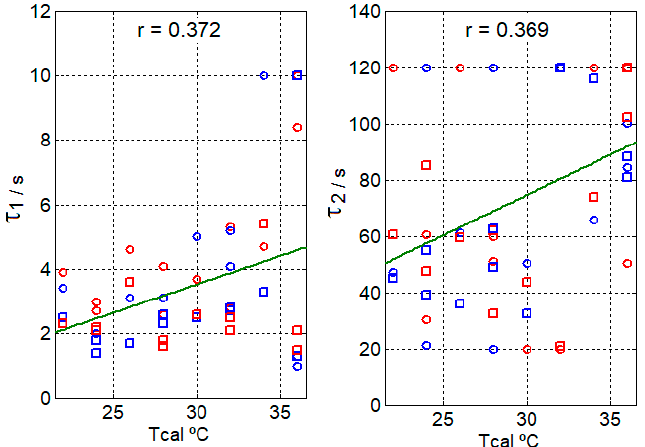
Figure 7. Time constants of the heat flux (Equation (5)) of the right hand (blue points) and the left hand (red points) of a healthy 23-year-old male subject, measured with the minisensor S1 (round) and the minisensor S2 (squares) for different thermostat temperatures ( Tcal ). r is Pearson’s linear correlation coefficient.